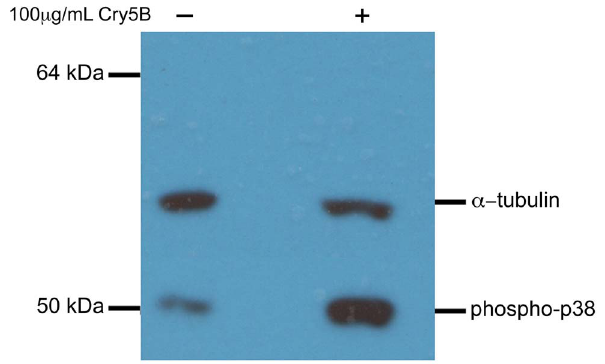
Figure 3. Cry5B treatment activates p38 MAPK in A. suum fourth-stage larvae (L4). Ascaris suum L4 were exposed to either buffer or Cry5B and then protein extracts prepared. Treatment with Cry5B results in significant up-regulation of activated (phosphorylated)